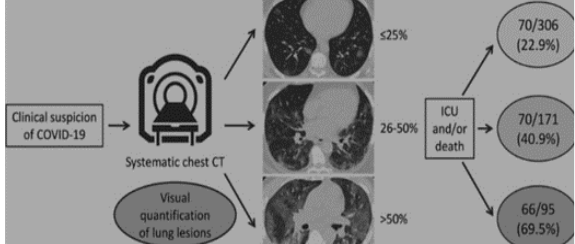
Figure 1.2: General analysis of CT scan